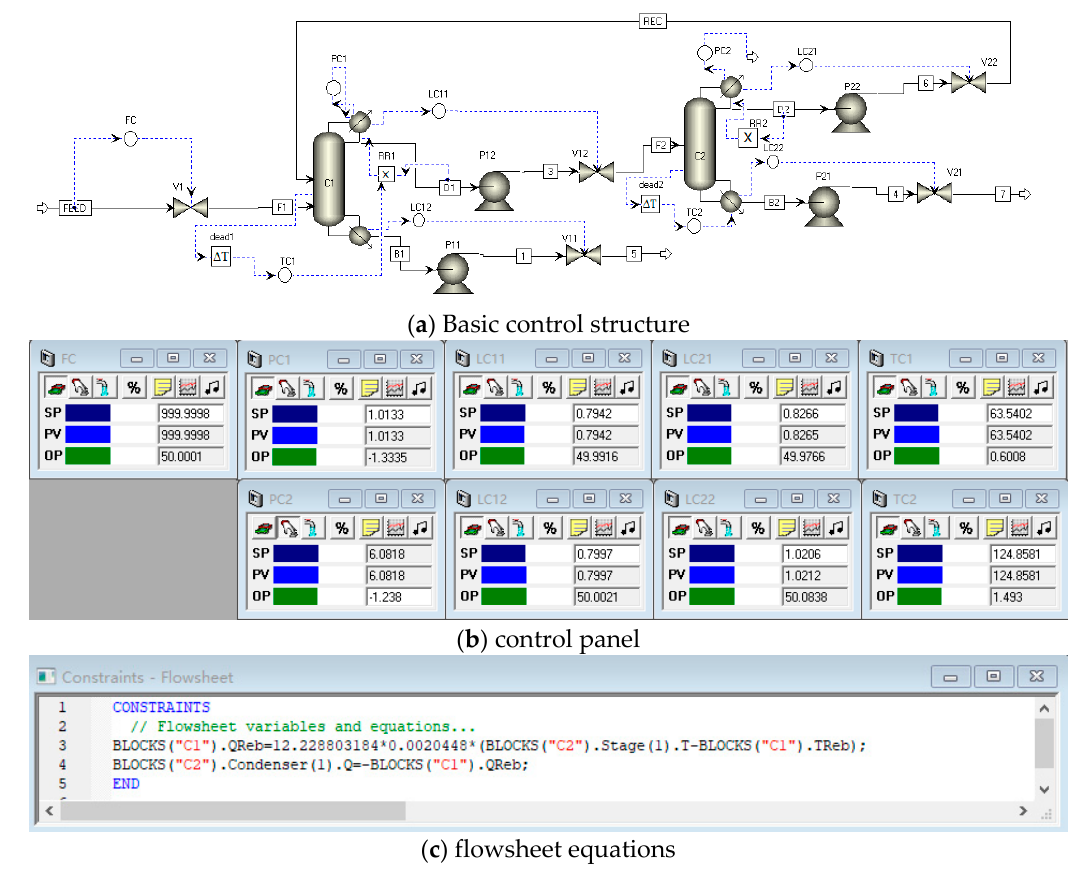
Figure 16. Basic control structure, control-panel, and flowsheet equations for the fully HIPSD process.